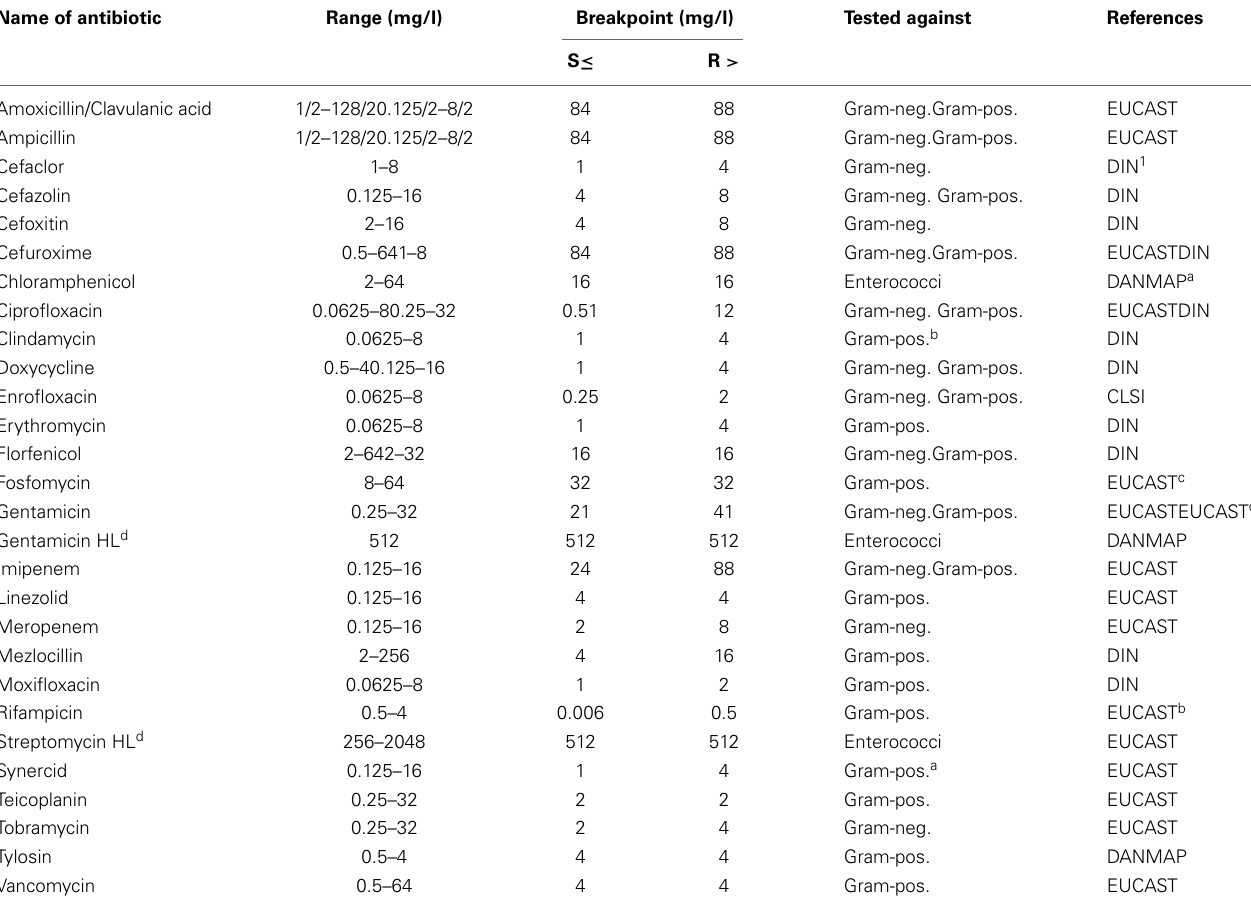
Table 1 | Antibiotic agents, concentration ranges, and